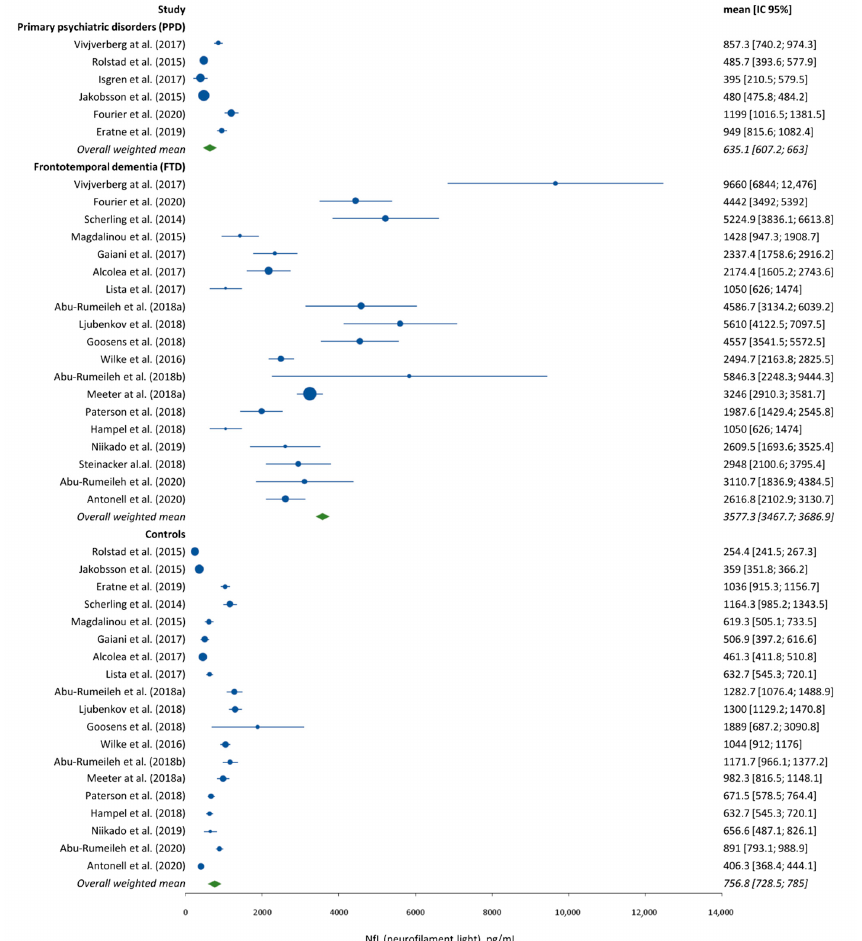
Figure 2. Forest plot analysis of CSF NfL levels in FTD, PPD, and control patients.